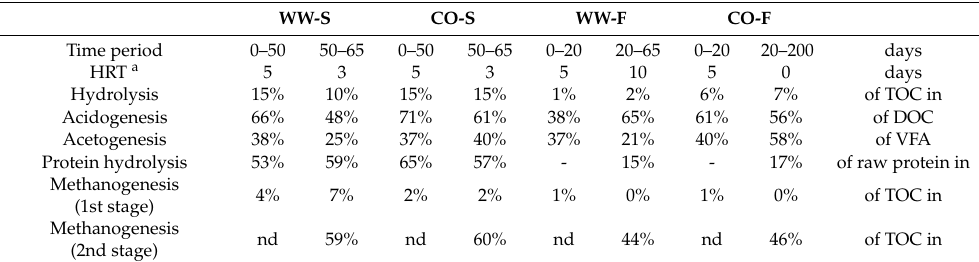
Table 2. E ffi ciency of the di ff erent steps in anaerobic digestion for the reactors fed mixed sludge (WW-S and CO-S) and the reactors fed food waste (WW-F and CO-F). TOC = total organic carbon, DOC = dissolved organic carbon, VFA = volatile fatty acids, nd = not